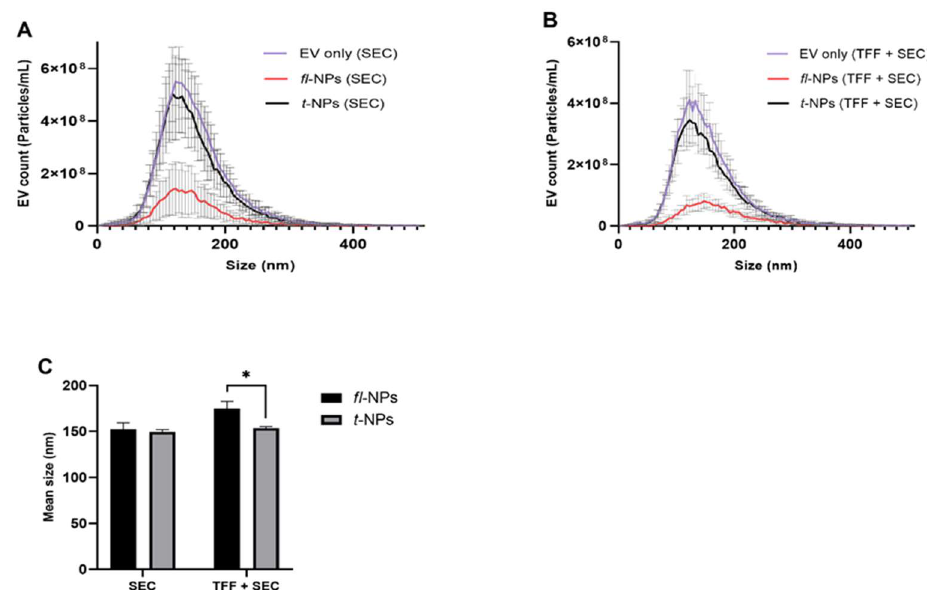
Figure 8. Size profile distribution for fluorescent and total NPs originating from JAr cells measured using Zetaview ® - NTA. Size profile distribution ( A , B ) and particle mean size ( C ) for JAr EVs purified in SEC alone and combination of TFF. EVs were labeled with 100 ng/mL of CMG and fl- NPs were measured at a minimum brightness threshold value of 25. The mean particle size of fl- NPs of JAr EVs purified with TFF and SEC was significantly different ( p ≤ 0.05) than the corresponding t-NPs of JAr EVs purified with TFF and SEC. Thus, were marked with an asterisk (*) symbol. EVs only as a control, fl- , and t-NPs of EVs were diluted in 1x PBS before being measured in fluorescent and scatter modes of NTA (mean ± SD, n = 9).